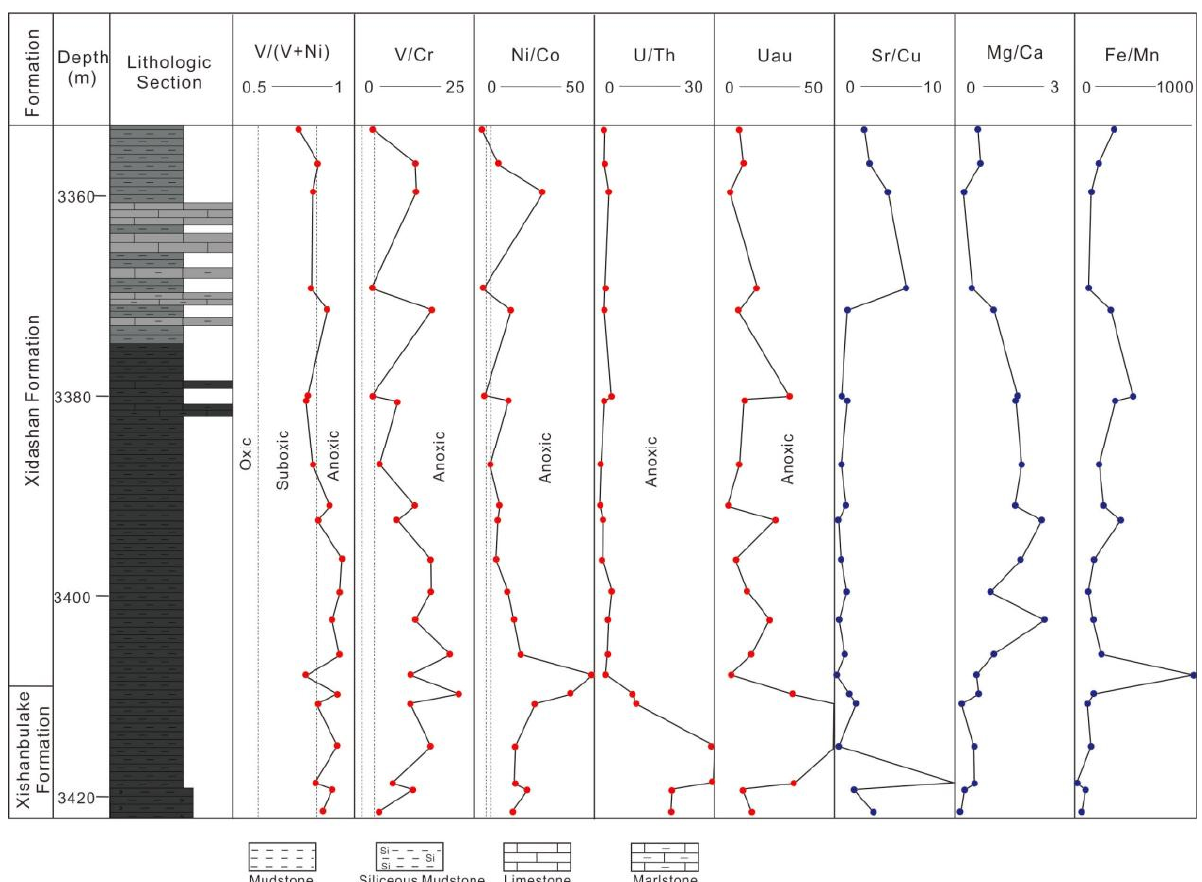
Figure 3. Variations in paleoredox and paleoclimate discrimination indices of the Lower Cambrian mudstone in the Kongquehe area.